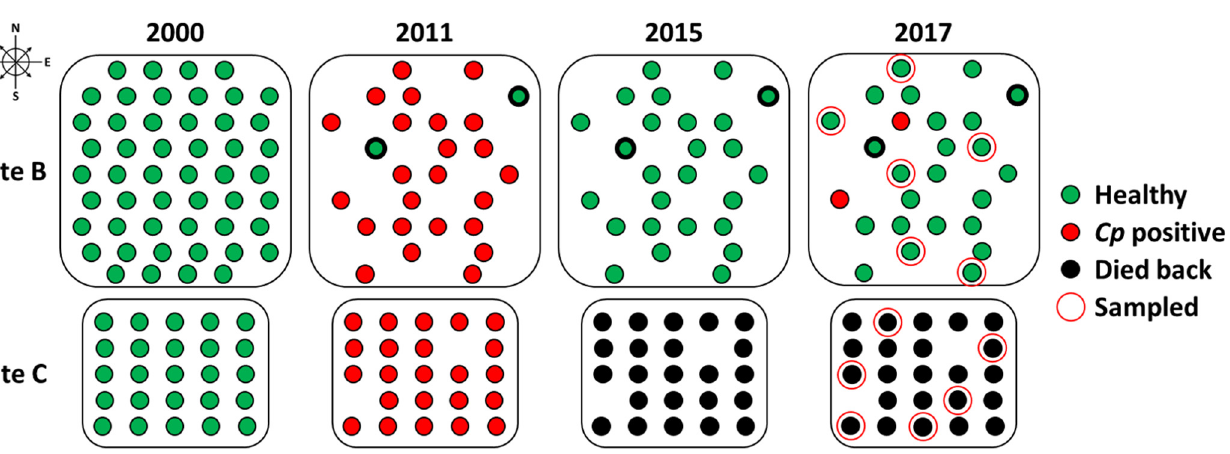
Figure 3. Disease progression. Representative depiction of disease presence at the Site B and Site C sites across several years. Tree mortality from causes unrelated to blight are excluded from 2011 onward.